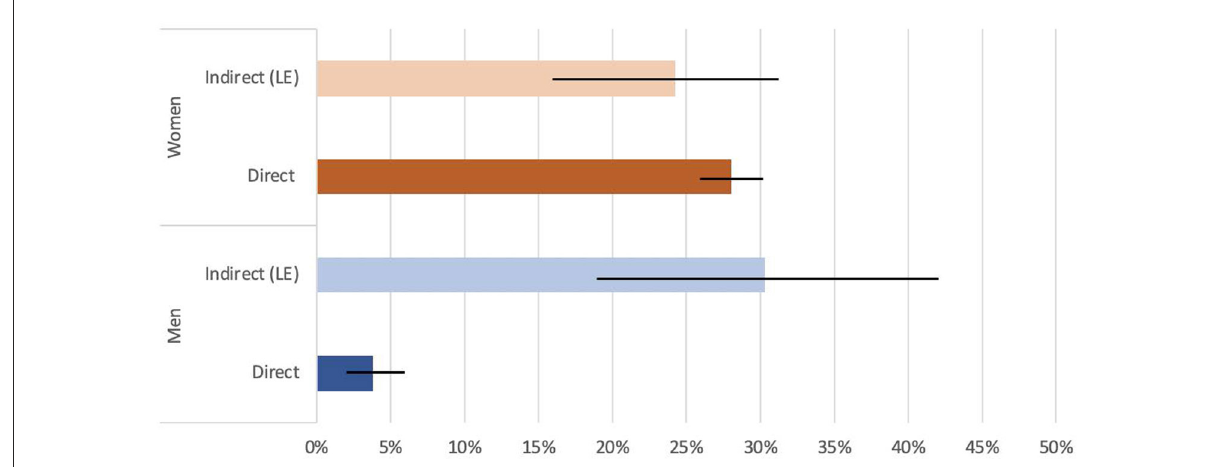
FIGURE1 Direct and indirect (List Experiment) physical IPV disclosure, stratified by sex.